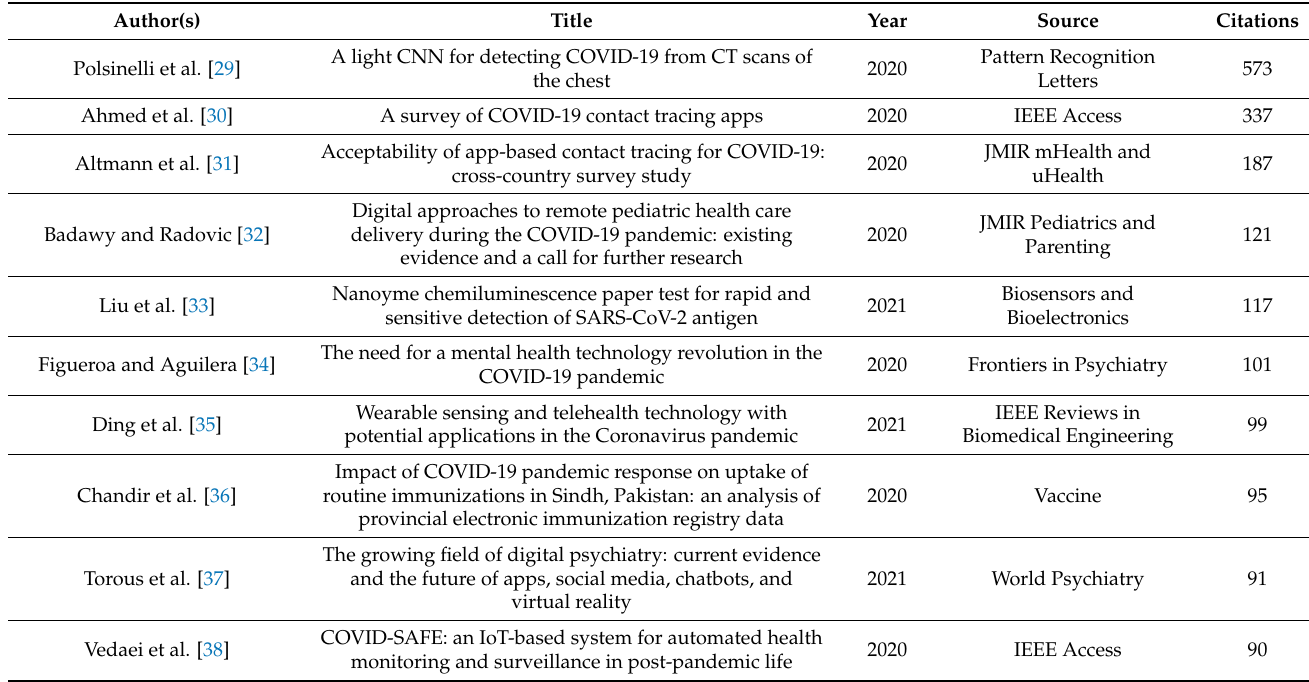
Table 6. Top 10 highly cited